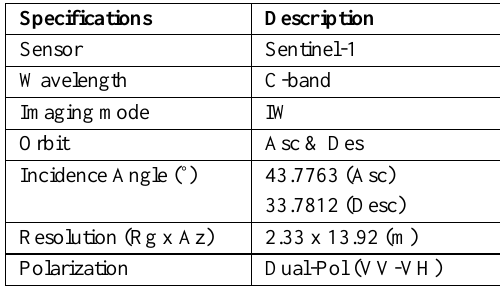
Table 1. Characteristics of